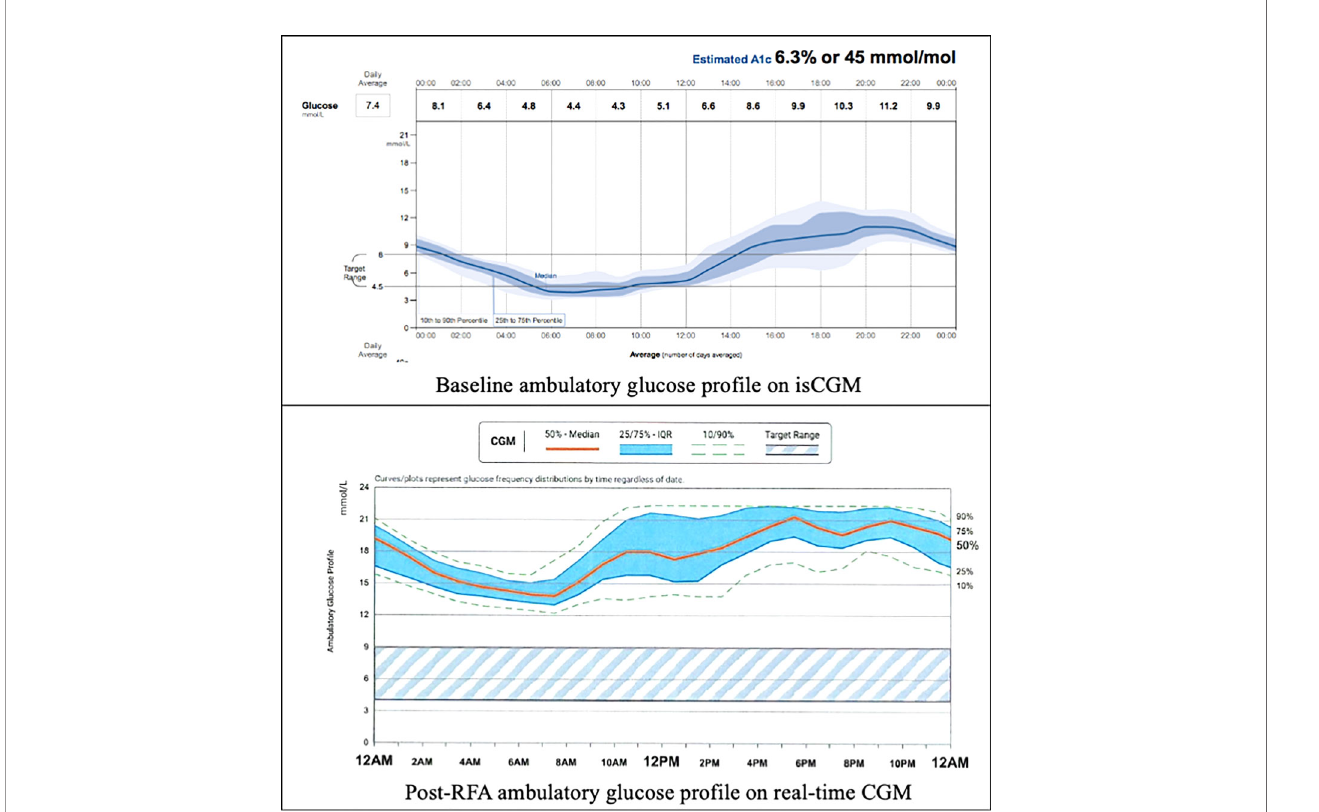
FIGURE 1 | Baseline and post-RFA ambulatory glucose pro fi le. isCGM, intermittently scanned continuous glucose monitoring; RFA, radiofrequency ablation; CGM, continuous glucose